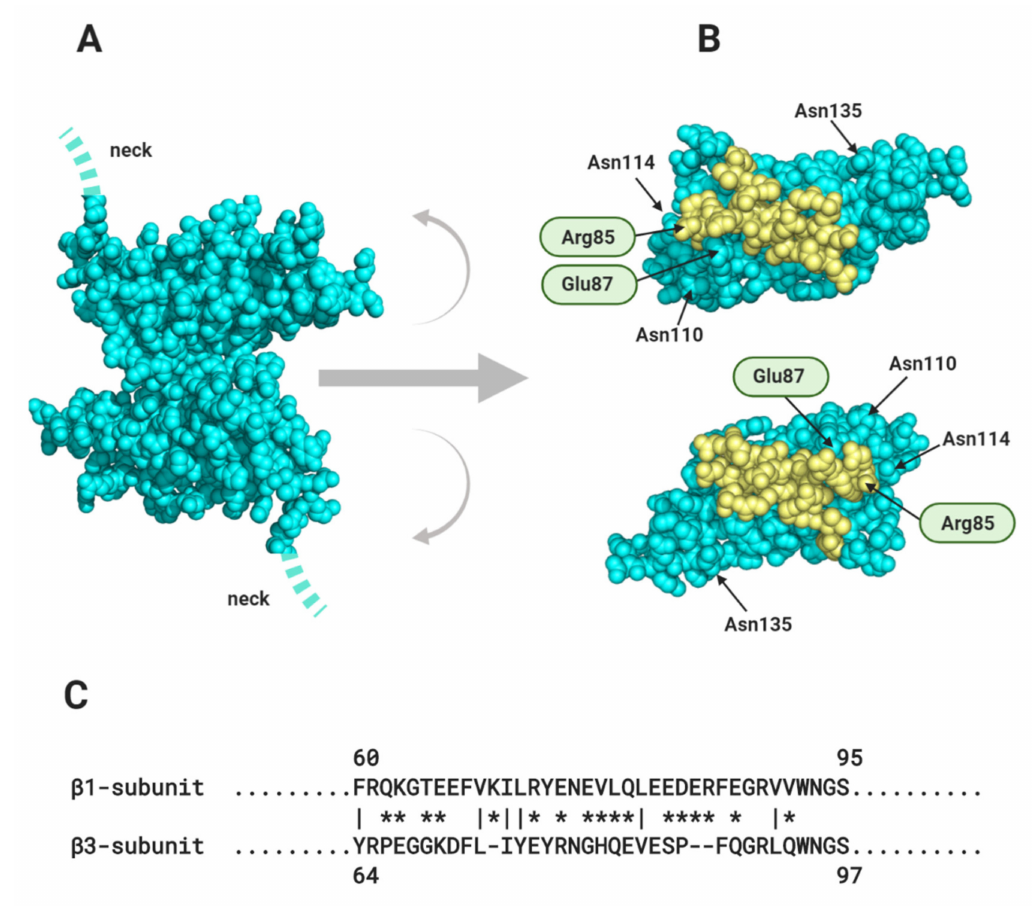
Figure 7. The proposed contact surface between the trans-interacting β 1 Ig domains. ( A ) The antiparallel arrangement of β 1 Ig domains. ( B ) the two β 1 Ig domains ‘peeled back’ to reveal the contact surface proposed by [66]. The location of two Brugada mutations (Arg85 and Glu87), mentioned in the text are indicated. Potential N-linked glycosylation sites, Asn110, Asn114 and Asn135 are indicated. ( C ) Sequence alignment between β 1 and β 3 Ig domains within the proposed contact surface, showing low sequence identity. Non-conservative changes are shown with asterisks and conservative changes with vertical